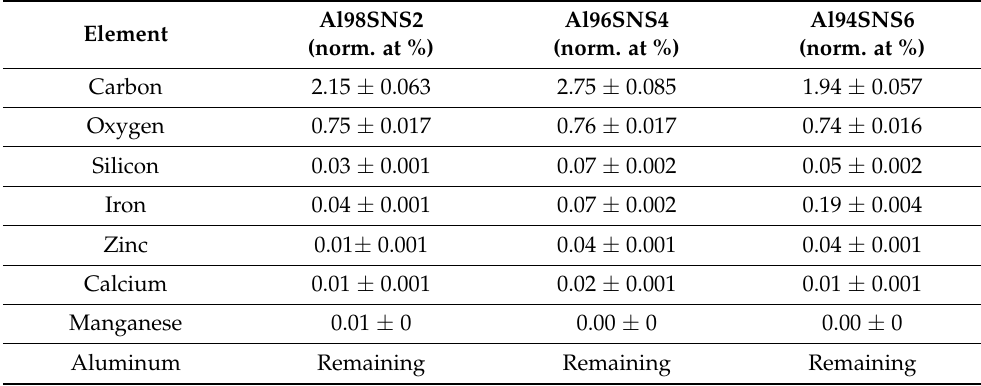
Table 3. EDS—elemental composition results before corrosion (at %); (the calculated SD is averaged from 10 measurements, 5 on each of the 2 replicates). Al98SNS2 Al96SNS4 Al94SNS6 Element (norm. at %) (norm. at %) (norm. at %) Carbon